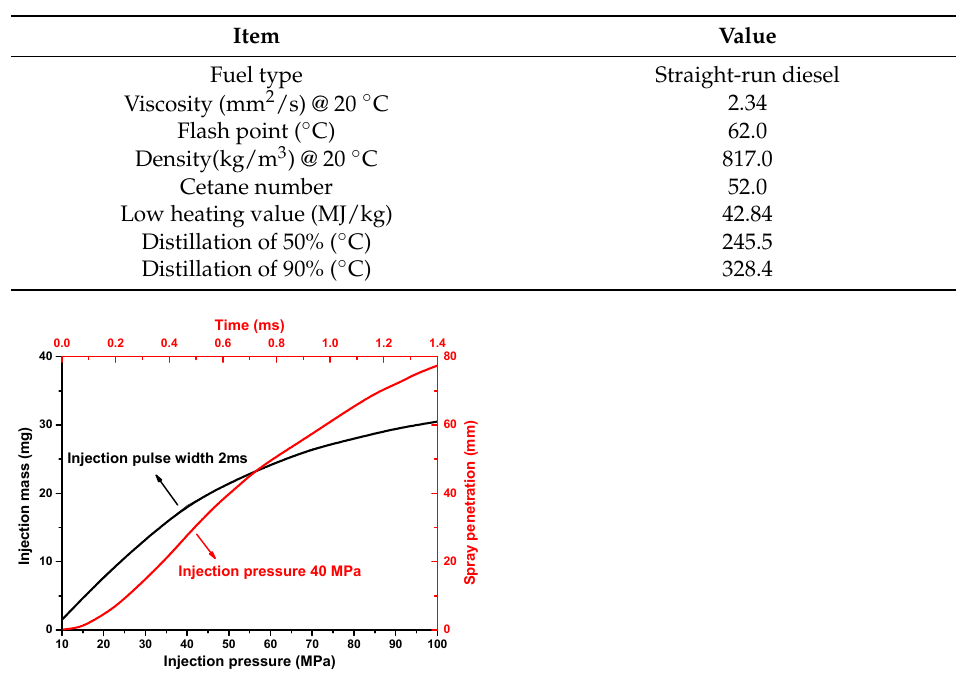
Table 1. Fuel properties for spray-wall impingement experiments.